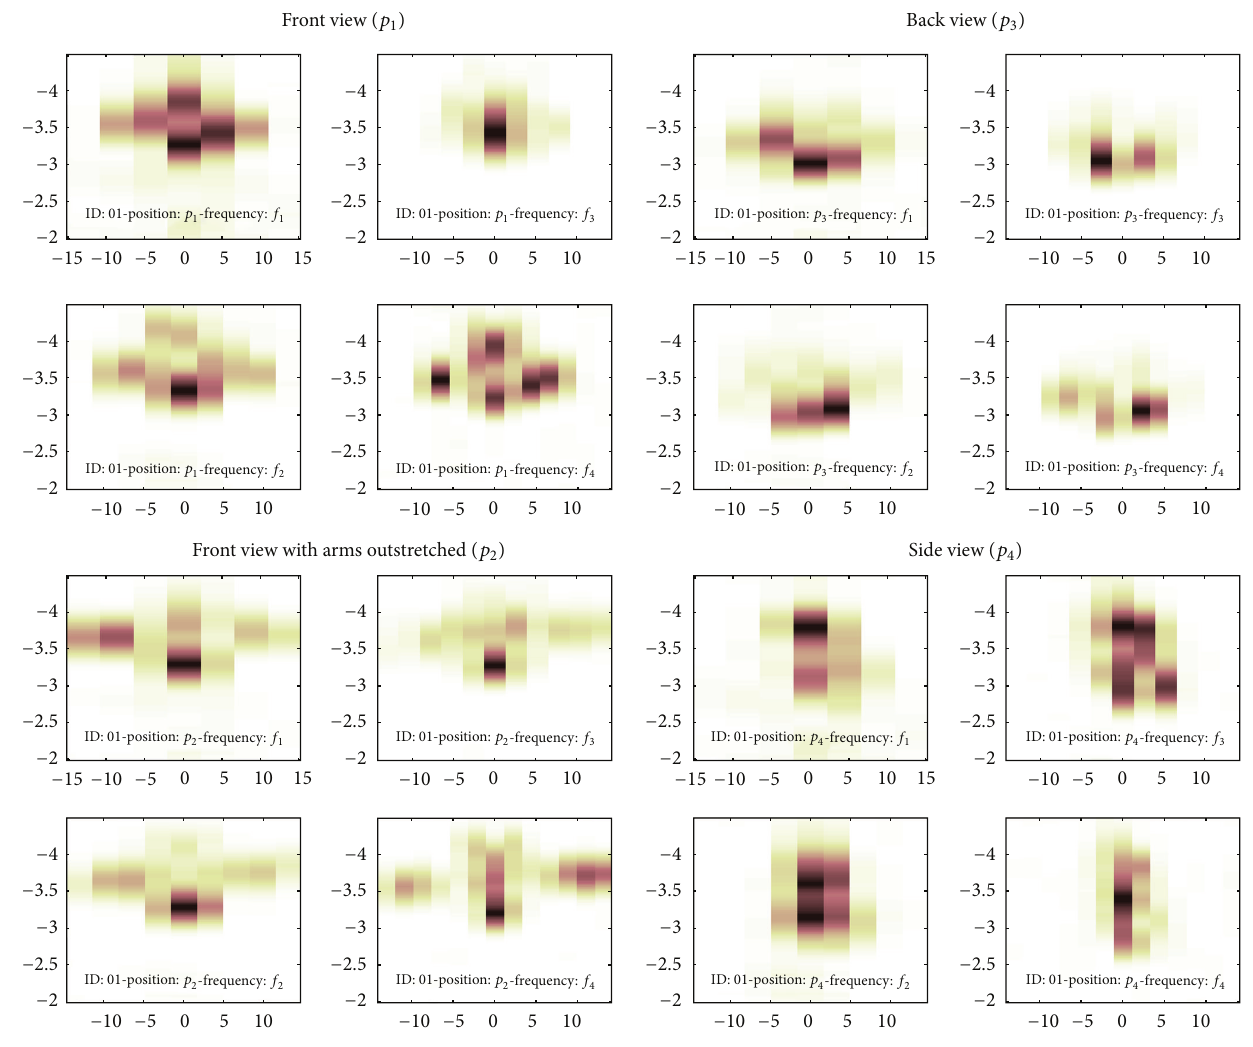
Figure 6: Acoustic images. 𝑥 -axis: angle (degrees); 𝑦 -axis: range